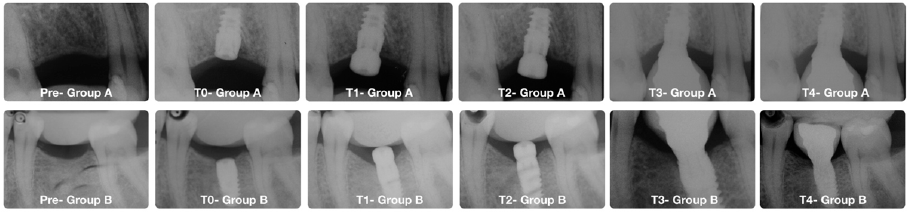
Figure 4. Radiographs from the two groups. In the upper images patient from Group A (control group) (clinical images are shown in Figure 3). In the lower images patient from Group B (test group). Pre (Image before the implant placement); T0 (after implant insertion); T1 (second surgical stage at 8 weeks); T2 (before the implant impression at 10 weeks); T3 (restoration’s delivery); T4 (1 year of